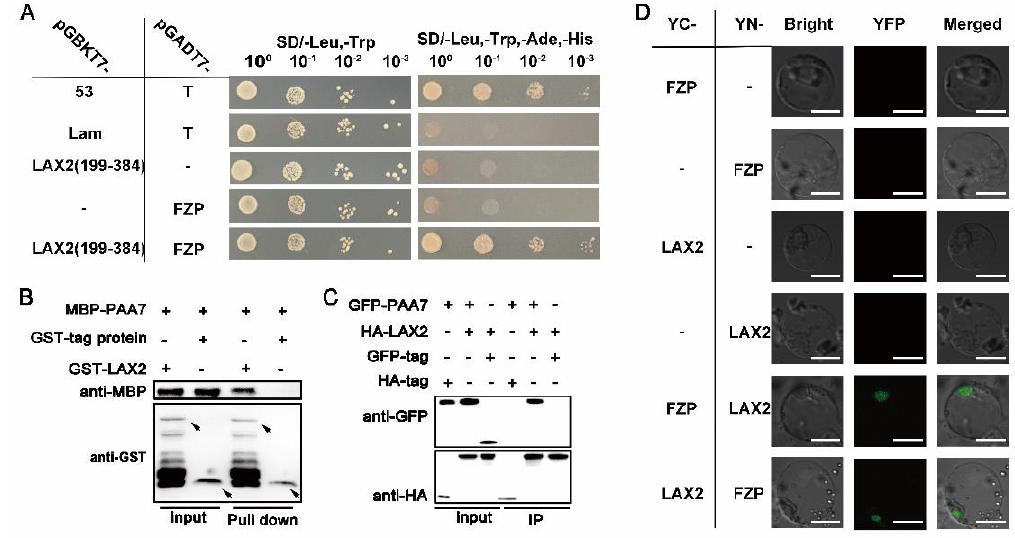
Figure 7. PAA7 interacts with LAX2. ( A ) Yeast two − hybrid assays showed the interaction between PAA7 and LAX2 proteins; pGBKT7 − 53 and pGADT7 − T pair was used as a positive control, the pGBKT7 − Lam and pGADT7 − T pair was used as negative control, and the pGBKT7 − LAX2 and pGADT7 pair was the self-activation test. ( B ) PAA7 binds LAX2 in vitro. MBP − PAA7 were incubated with GST − LAX2 and pulled down by GST − LAX2 and detected by immunoblot with anti − MBP ant-body. ( C ) Co − IP assay confirmation of PAA7 and LAX2 interaction. ( D ) Bimolecular fluorecence complementation (BiFC) assay showed that PAA7 and LAX2 proteins interact in the nucleus of rice protoplasts. Bar = 10 µm.